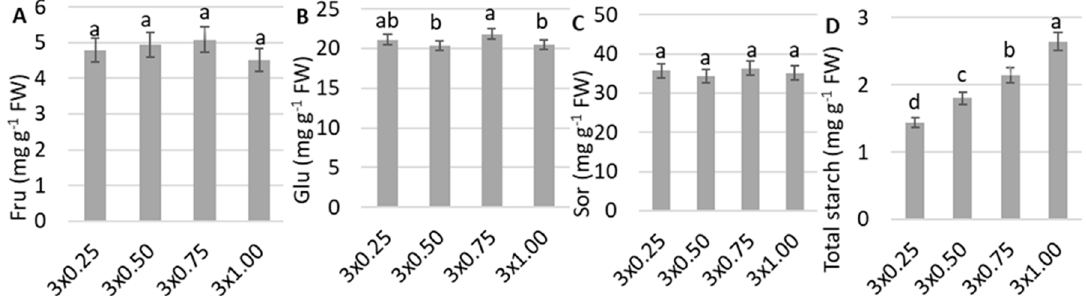
Figure 7. Effect of distances between trees regardless seasonality on fructose–Fru ( A ), glucose–Glu ( B ) sorbitol–Sor ( C ), and total starch ( D ). The different letters in graphics indicate significant differences. The data were processed using analysis of variance (Anova), the Turkey (HSD) test at the confidence level p = 0.05.